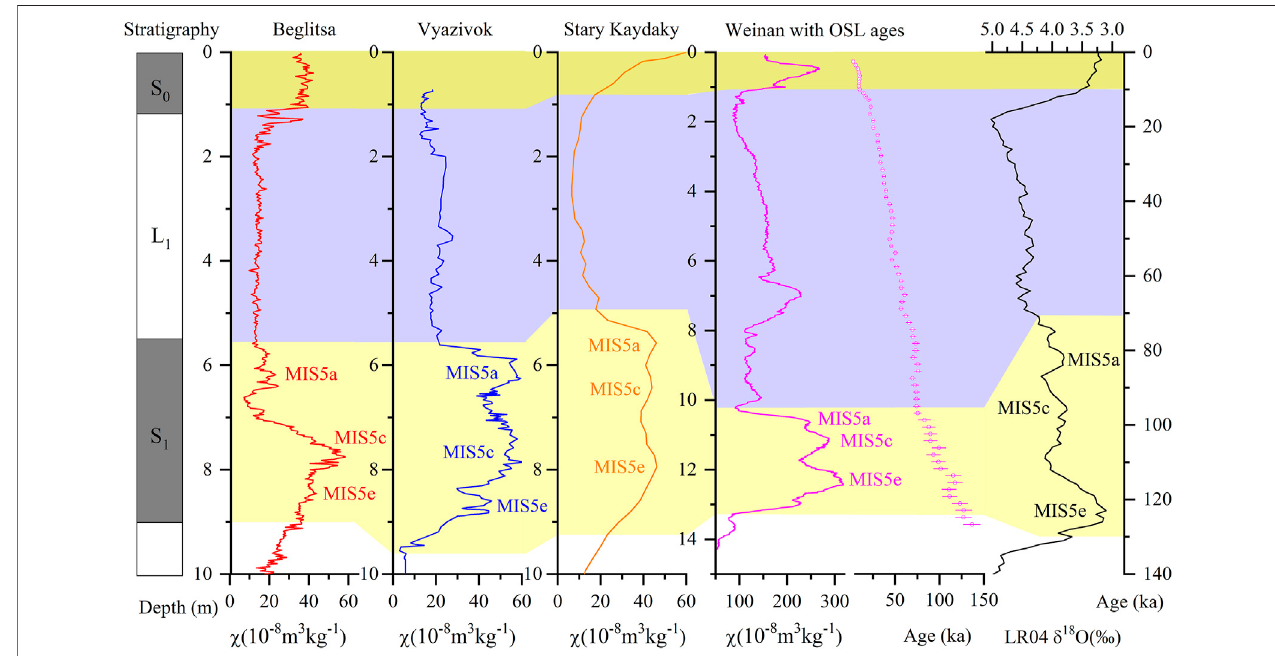
FIGURE8| StratigraphyoftheBeglitsasectionanditscorrelationwithotherloessrecordsontheEastEuropeanPlainandCLPbasedonthe χ lf proxy,andwiththe benthicLR04stack.Vyazivok,Ukraine(HlavatskyiandBakhmutov,2020);StaryKaydaky,Ukraine(Buggleetal.,2009);Weinan,China(Kangetal.,2011,2013);andthe benthic LR04 stack (Lisiecki and Raymo, 2005). For location of sections on the East European Plain, please refer to Figure 1 .